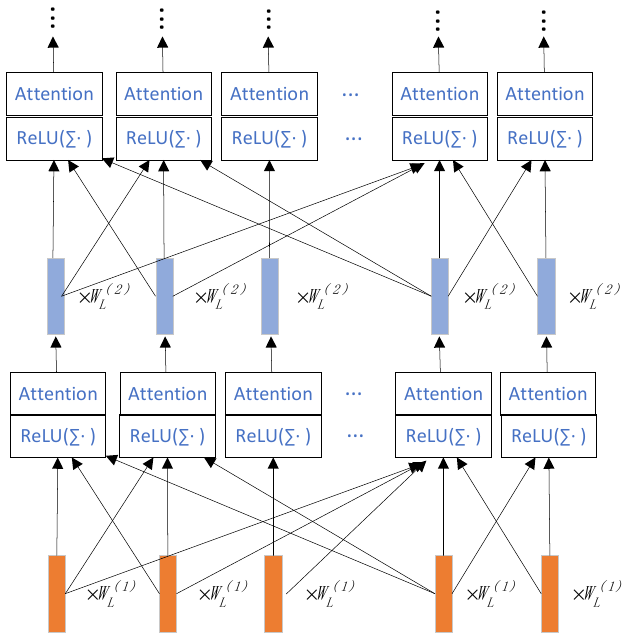
Figure 3. Illustration of the GCN architecture.